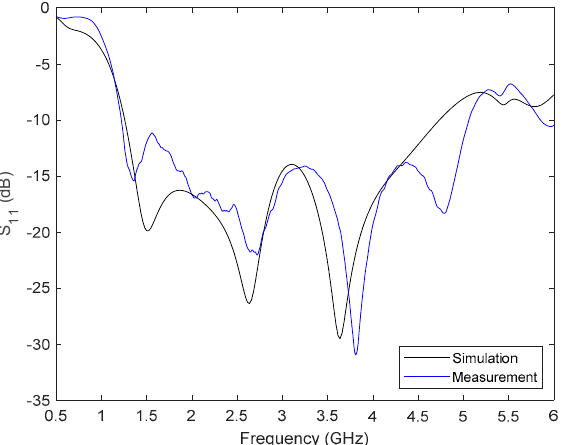
Figure 3. Measured and simulated return losses for the proposed antenna.